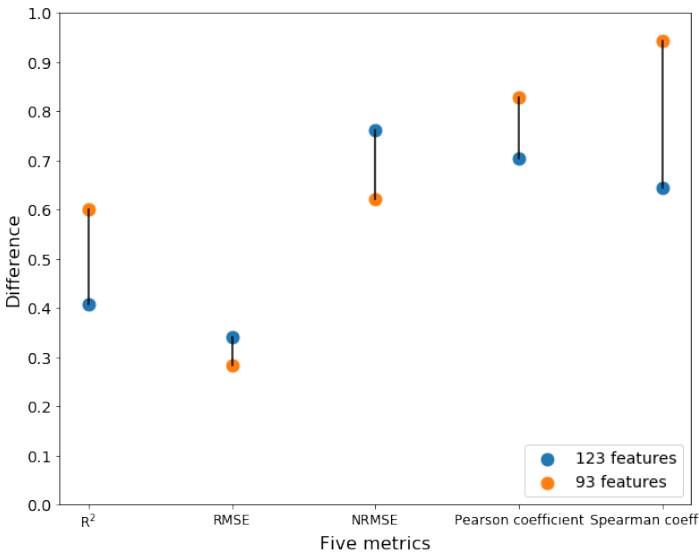
Figure 5. Differences in five performance measures between 93 features (the best feature subset) and 123 features (the feature subset) proposed in Wang’s work. R 2 , Pearson’s, and Spearman’s correlation coefficients of 93 features are higher than those of 123 features, and RMSE and NRMSE are lower than those of 123 features.